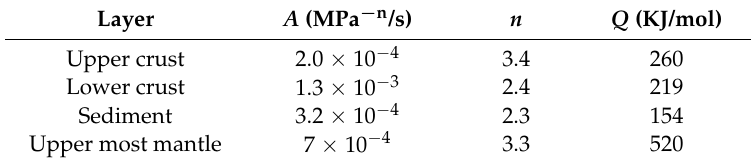
Table 3. Rheological properties of different lithospheric layers (Ranalli, [50] and references therein).